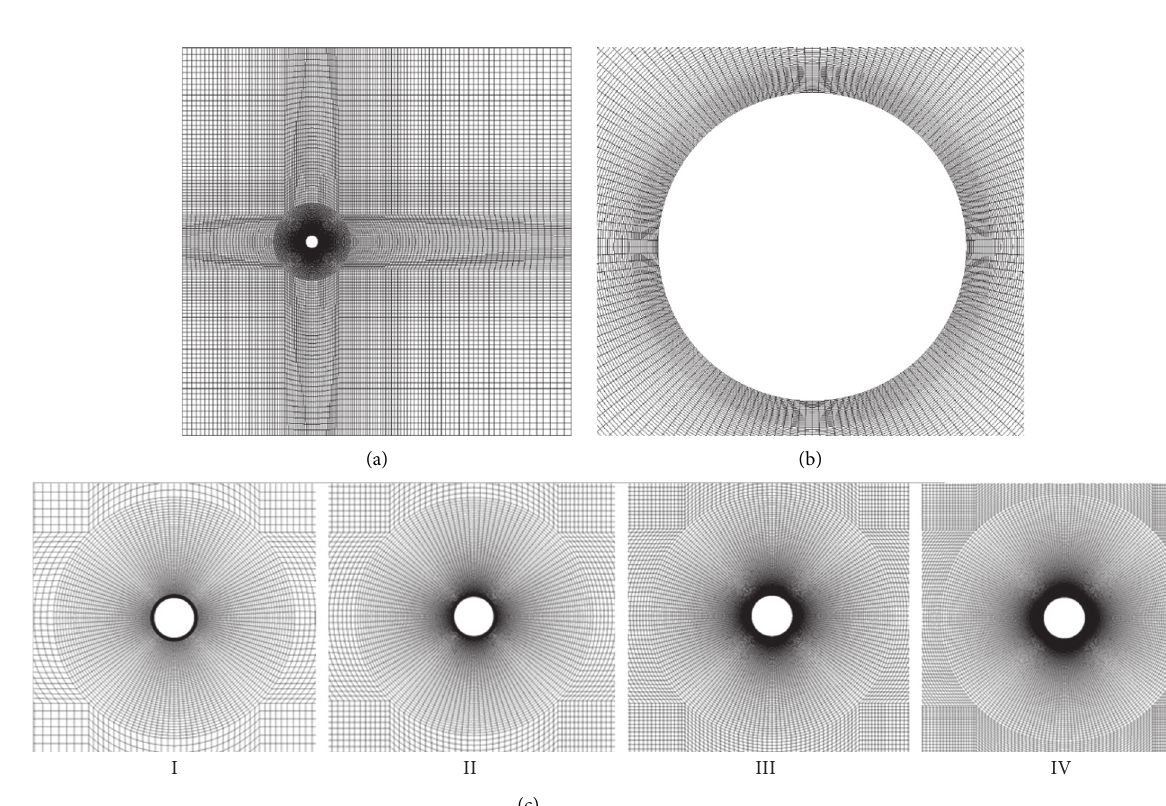
Figure 2: (a) Uniform mesh for the global domain; (b) boundary layers around cylinder; (c) details of the four meshes around the